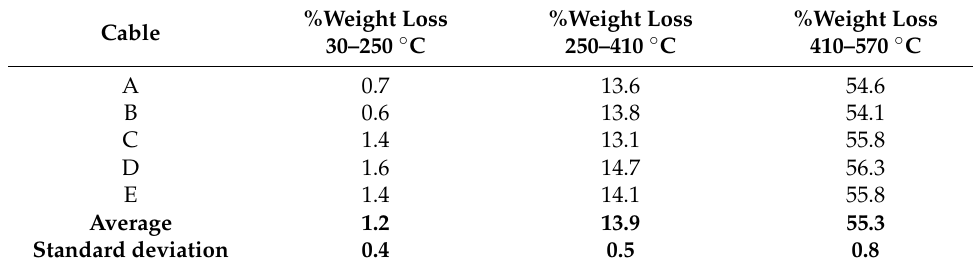
Figure 6. TGA curves of jacket layers for virgin and naturally aged cables, under condition I (heating rate of 25 ◦ C min − 1 ). A–E stand for different ESP cables as denoted in the Experimental section. Table 4. Weight losses of the jacket layer for the cables A–E evaluated under condition